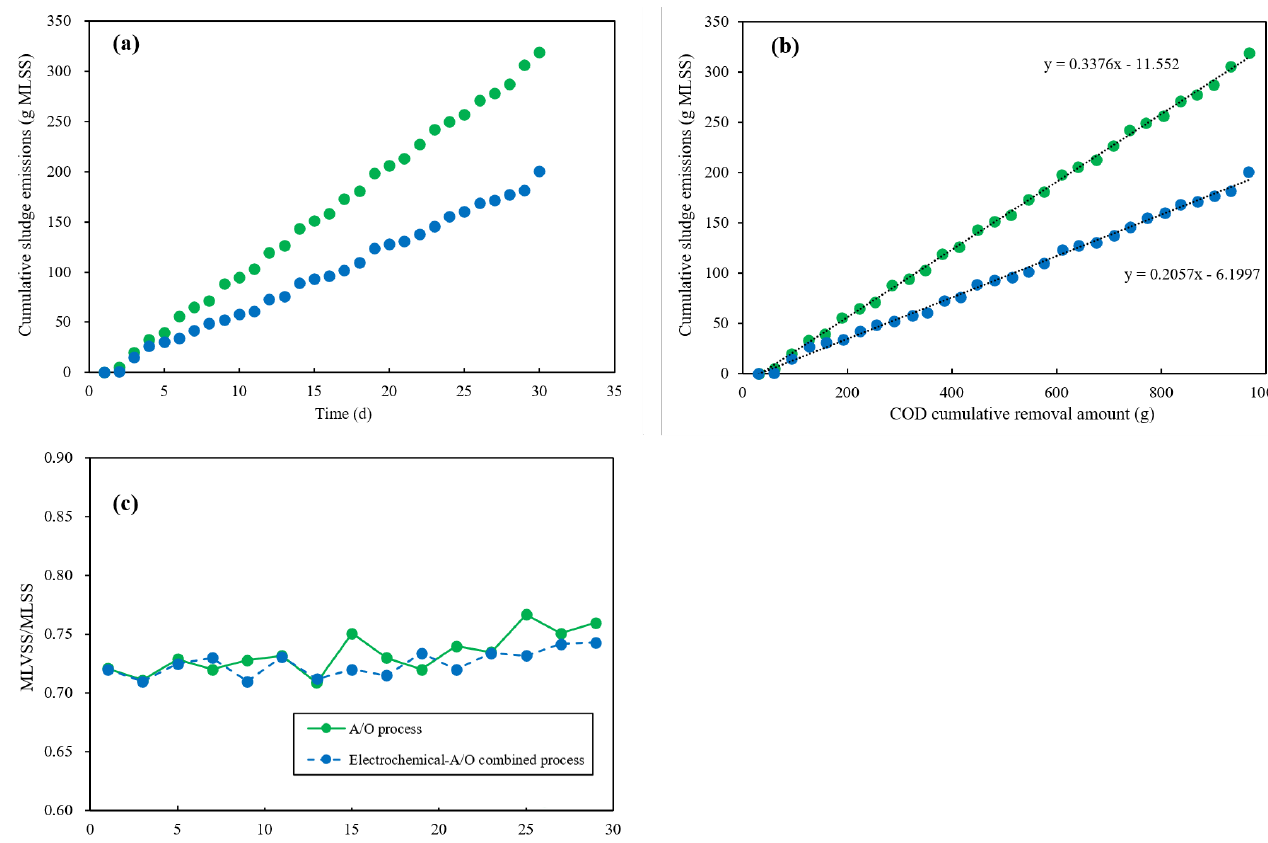
Figure 2. ( a ) Cumulative sludge discharge within 30 days. ( b ) Relationship between cumulative sludge discharge and cumulative COD removal. ( c ) MLVSS/MLSS changes in the two sets of processes.